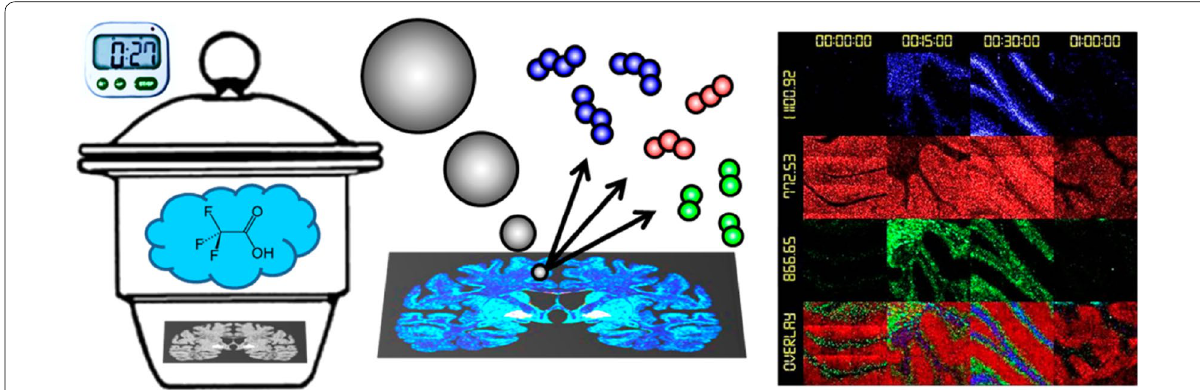
Fig. 5 Schematic of the workflow for lipid imaging with SIMS following exposure to TFA vapor. Tissue slices on microscope slides with an electrically conductive coating (indium tin oxide, ITO) were placed in a desiccator containing 300 μL of TFA for different lengths of time. The samples were transferred to the mass spectrometer for SIMS analysis where the tissue was bombarded with a focused beam of Ar 4000 + ions. Several hundred peaks with distinct mass signals were detected of which selected lipid species were imaged (Reproduced from ref. [91] with permission, © American Chemical